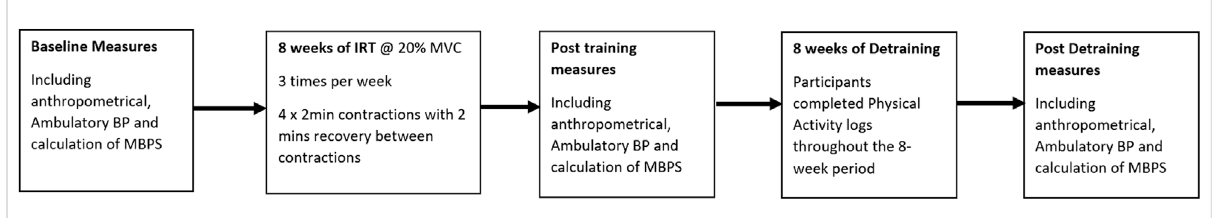
FIGURE 1 Study fl ow diagram illustrating the Isometric resistance training (IRT) and detraining periods and the points of blood pressure